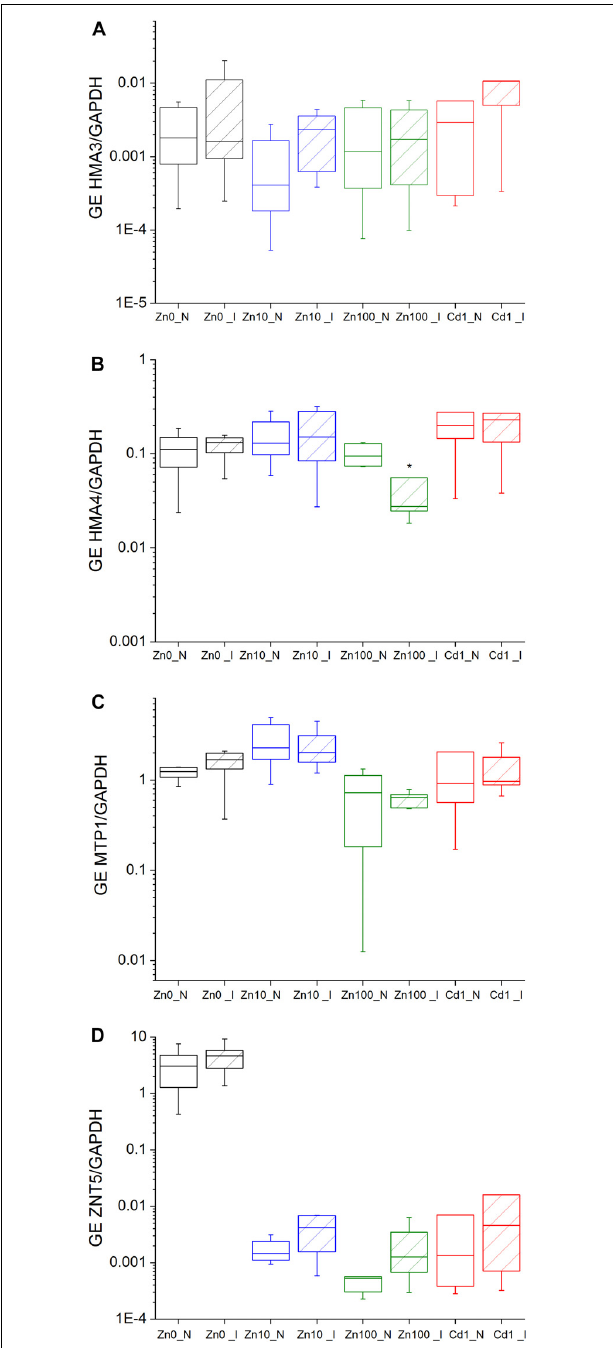
FIGURE 3 | Complete NPQ ((F m -F m ’)/F m ) during the irradiance phase. Zn0 (A) , Zn10 (B) and Zn100 (C) refer to Zn concentrations used in the treatments (‘0’ = 0.01, 10 and 100 µ M Zn), Cd1 (D) refers to a 1 µ M Cd + 10 µ M Zn treatment. The line presents the median value ( n = 6–8), the box shows the values between the 0.25–0.75 percentiles, and the bars show whiskers with 1.5 coefficient for outliers. Asterisks denote significant differences between infected and non-infected N. ochroleucum plants within the same Zn treatment according to the Mann–Whitney test. F m , maximal chlorophyll fluorescence in dark-adapted state; F m ’, maximal chlorophyll fluorescence in light-adapted state; NPQ was measured from the beginning (i1) to the end (i6) of the 200 s actinic light phase using 600 ms flashes of saturating light.